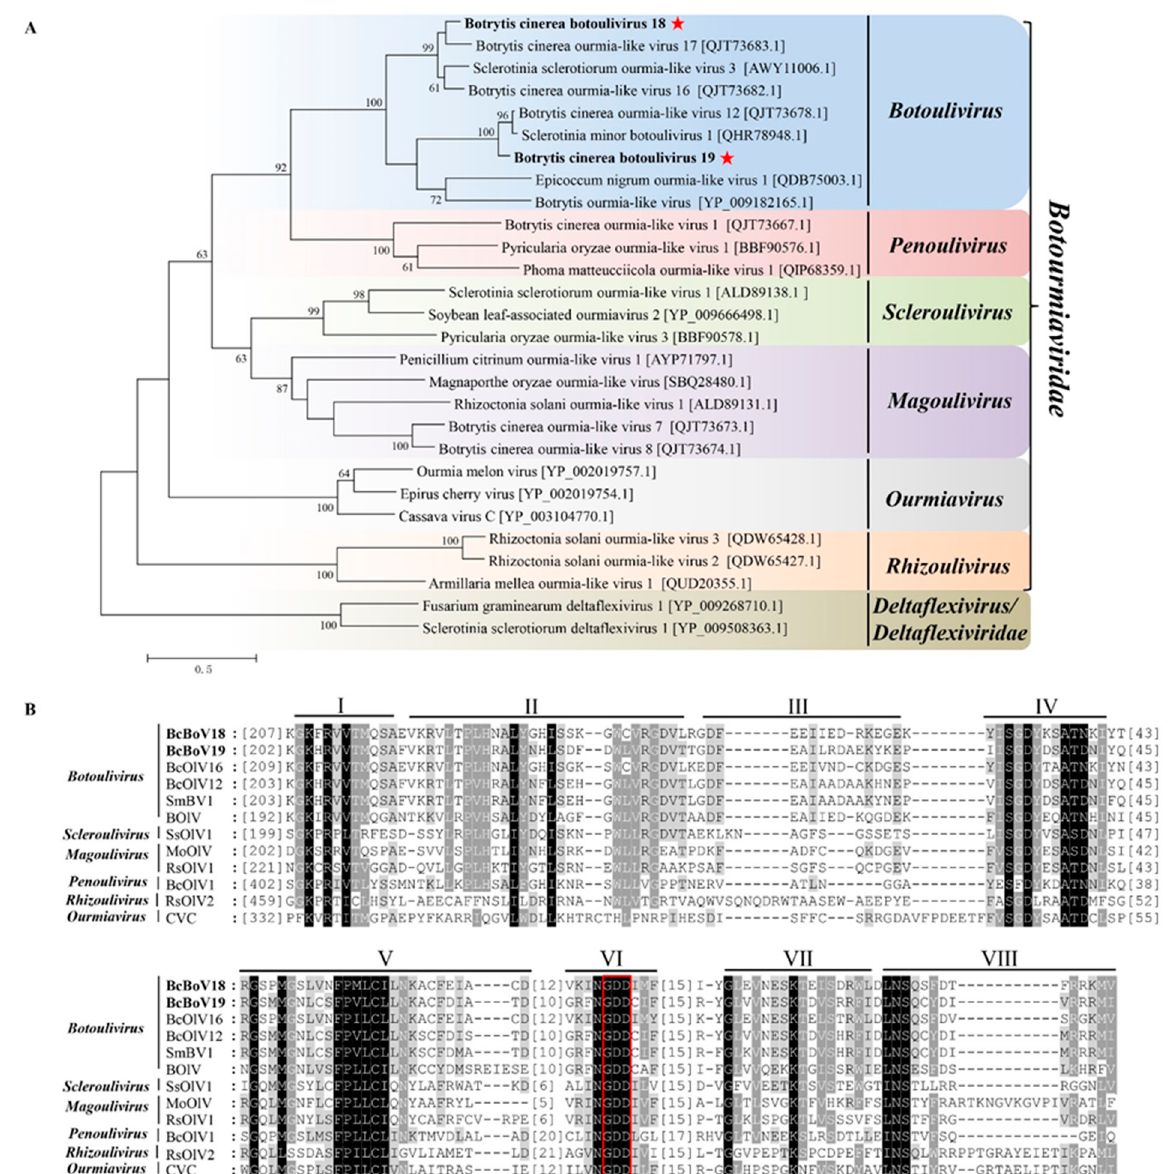
Figure 5. Phylogenetic tree depicting the relationships and: ( A ) multiple alignments of predicted RdRp aa sequences from; Botrytis cinerea botoulivirus 18, Botrytis cinerea botoulivirus 19 (indicated in the bold letters with red pentagrams)_are clustered into the genus Botoulivirus . ( B ) BcBoV18 and BcBoV19 (indicated with bold letters) in this study with members of Botoulivirus , Penoulivirus , Scleroulivirus , Magoulivirus , Ourmavirus and Rhizoulivirus in the Botourmiaviridae family. The conserved RdRp motifs are indicated using Roman numerals from I to VIII for BcBoV18 and BcBoV19. The red box indicated the conserved GDD motifs.